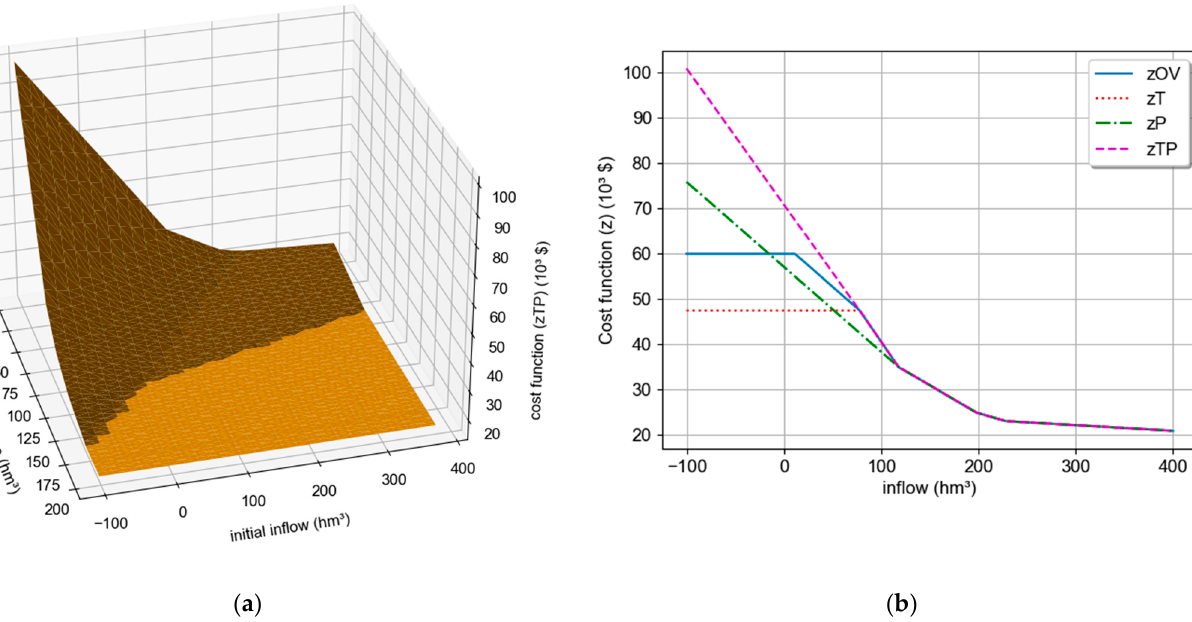
Figure 8. ( a ) Cost function (zTP) (10 3 $) per inflow(hm 3 ) by the truncation approach. ( b ) Comparison between the cost function (z) (10 3 $) by the optimal value approach (solid blue), truncation approach (dotted red), penalty approach (dash and dot green), and penalty with truncation (dashed magenta).